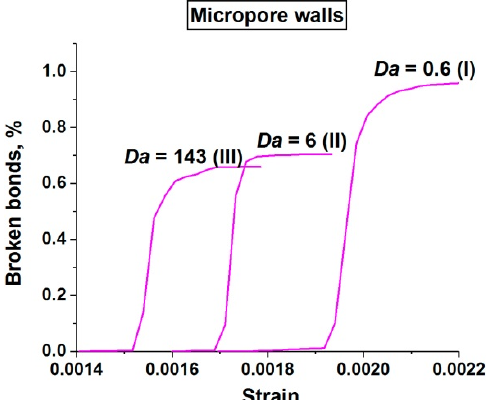
Figure 13. The dependence of the number of broken bonds in the walls of micropores in the fluid-saturated concrete sample with two-scale pore structure (capillary porosity and 4 vol.% micropores) on the value of applied strain. The number of broken bonds is normalized by the total number of bonds in the unstrained sample. Roman numerals I, II, and III denote the number of the corresponding section of the unified curve σ comp ( Da ).